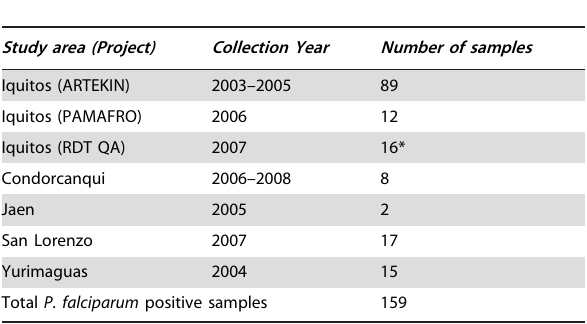
Table 1. Origin of the P. falciparum samples